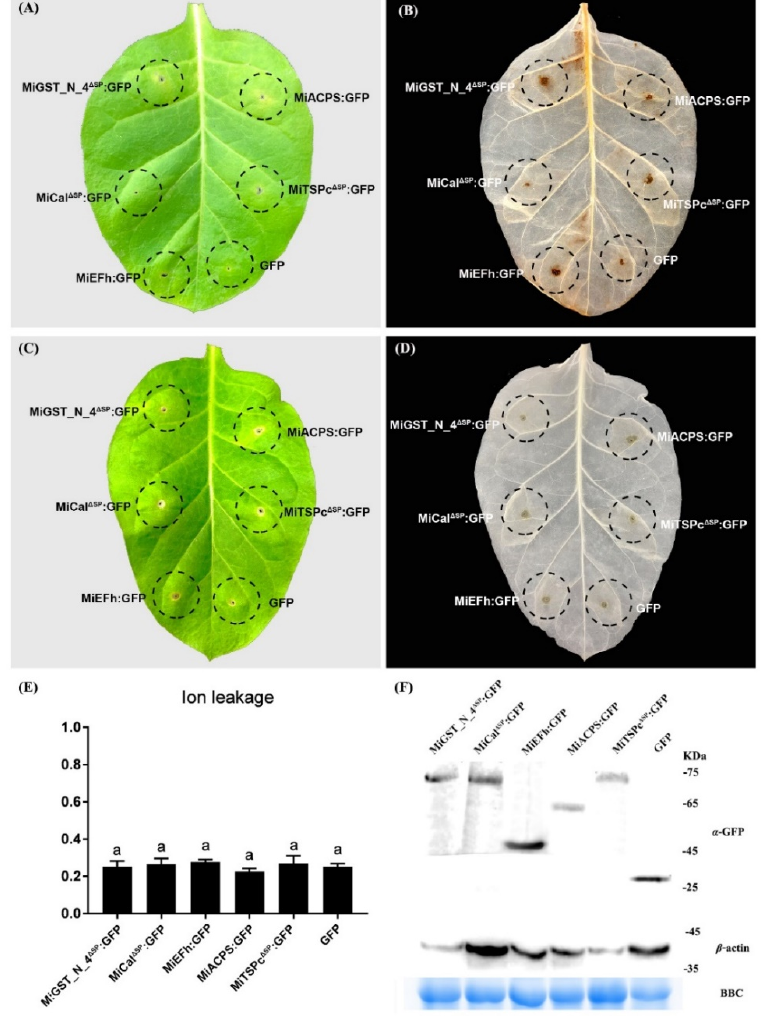
Figure 6. Analysis of reactive oxygen species (ROS) and hypersensitive response (HR) after inocu ‐ lation of five effectors in the leaves of RKN ‐ susceptible tobacco variety W38. The experiment was repeated at least three times, and each assay consisted of at least five plants with three leaves inoc ‐ ulated similarly. ( A , C ) The left panel shows a representative leaf of A. tumefaciens GV3101 carrying the vectors of MiGST_N_4 Δ SP : GFP, MiCal Δ SP : GFP, MiEFh: GFP, MiACPS: GFP and MiTSPc Δ SP : GFP constructs injected into the leaves RKN ‐ susceptible tobacco variety W38. Five representative leaves were photographed after 5 days. OD 600 = 1. ( B ) shows leave cleared with 3,3 ′‐ diaminobenzidine blue (DAB). The brown area represents H 2 O 2 localization. ( D ) Leaves cleared by ethanol injected with effectors after 5 days. ( E ) Ion leakage (mean ± SE, n > 5) was measured after injecting the effector 72 h. Error bars represent ± SD of three independent experiments. Letters on the bars indicate variabil ‐ ity between samples ( p < 0.05). Different letters indicate significant differences based on one ‐ way analysis of variance (ANOVA) followed by Duncan’s multiple range test. ( F ) Normal expression and accumulation of all tested proteins in leaves as indicated by Western blotting analysis. Coo ‐ massie brilliant blue (CBB) staining was used to show equal up ‐ sampling of protein samples.